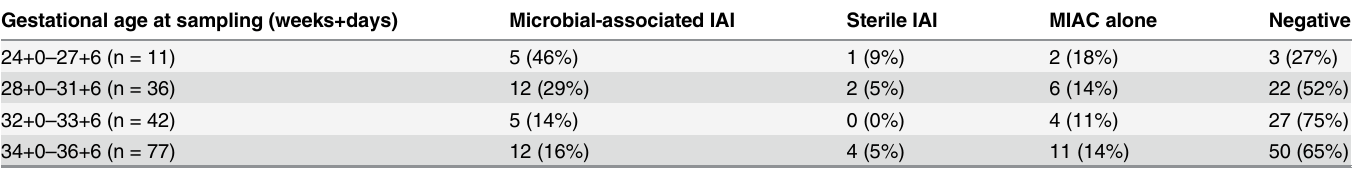
Table 2. Prevalence of microbial-associated intraamniotic inflammation, sterile inflammation and microbial invasion of the amniotic cavity alone according to the gestational age at sampling. Gestational age at sampling (weeks+days) Microbial-associated IAI Sterile IAI MIAC alone Negative 24+0 – 27+6 (n = 11) 5